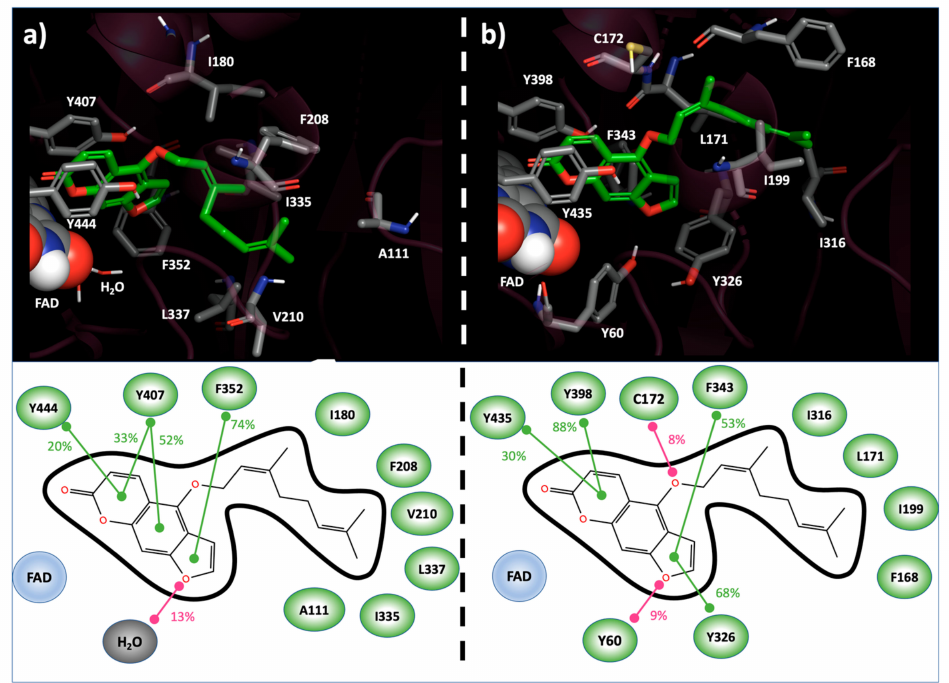
Figure 1. Bergamottin binding modes into the h MAO-A ( a ) and h MAO-B ( b ) active site resulting from MD simulation. In 3D representation ( top ), interacting residues and Bergamottin are reported in CPK and green-carbon-colored sticks, respectively. FAD cofactor is represented as spheres. In 2D scheme ( bottom ), ligand–target interactions, monitored during the MD simulation, are reported. Stacking contribution are depicted as green lines, hydrogen bonds as magenta lines. Frequencies of each interaction are indicated as